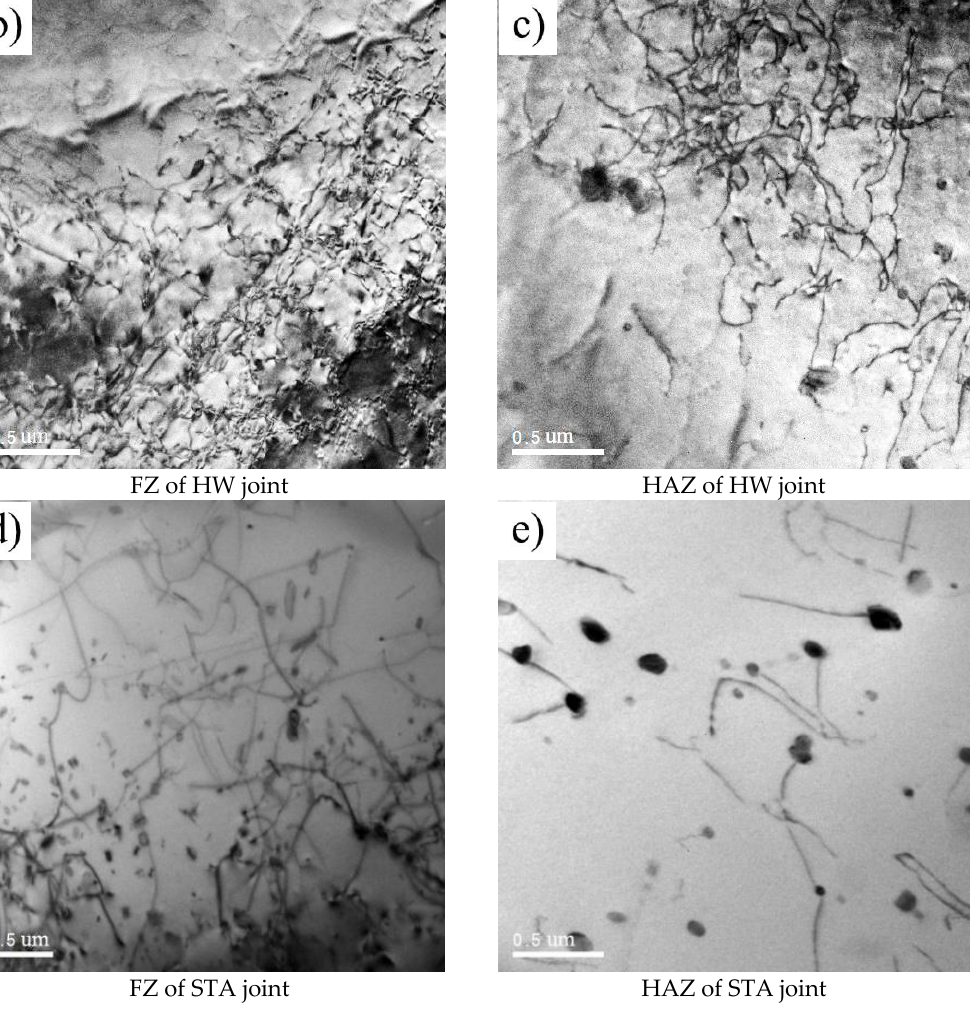
Figure 11. Dislocation structures in 6061-T6 hybrid welded and solution and aging (STA) joints.